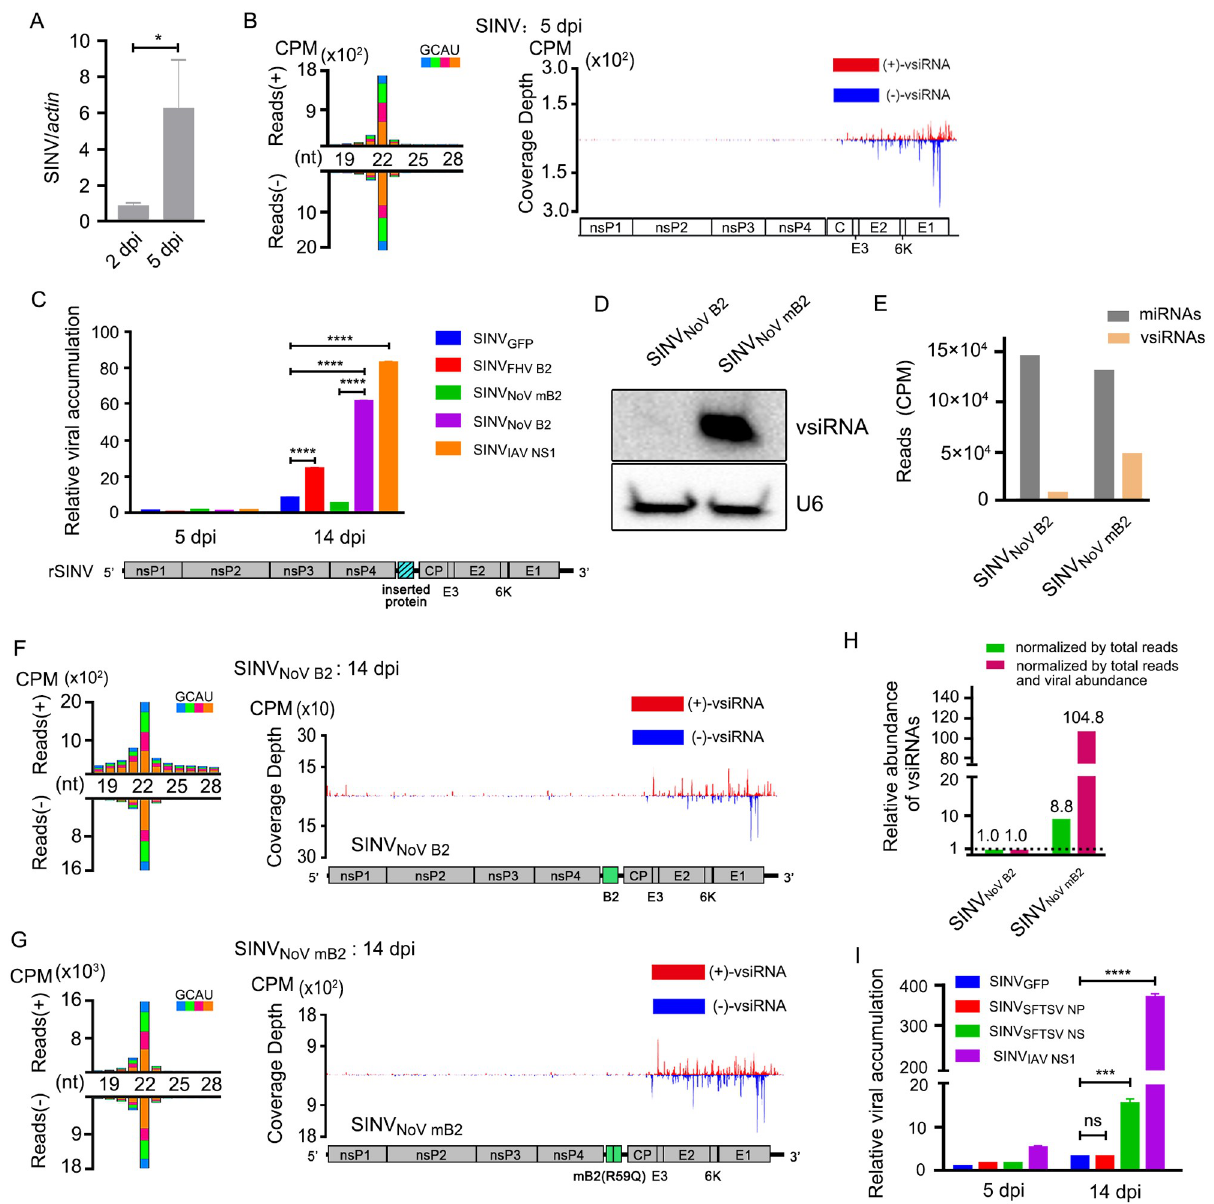
Fig 6. Infection of H . longicornis ticks with recombinant SINVs expressing heterologous VSR proteins. (A) SINV RNA levels in H . longicornis ticks infected with SINV by microinjection at 5dpi were determined by RT-qPCR. The viral RNA levels were calculated by Δ Ct method and tick β -actin mRNA was used as the internal reference. (B) Size distribution of virus-derived small RNAs and genomic coverage depth of 21- to 23-nt vsiRNAs sequenced from ticks infected with SINV by microinjection at 5 dpi. (C) Relative viral accumulation determined by RT-qPCR in ticks after infection with SINV GFP , SINV NoV B2 , SINV NoV mB2 , SINV FHV B2 , and SINV IAV NS1 by injection at 5dpi and 14 dpi. The viral RNA levels were calculated by ΔΔ Ct method. Tick β -actin mRNA as the internal reference. (D) Northern blotting detection of vsiRNAs in SINV NoV B2 and SINV NoV mB2 infected ticks by microinjection at 14 dpi. U6 as a loading control. (E) Reads of mature miRNAs and vsiRNAs in the library of SINV NoV B2 or SINV NoV mB2 infected ticks by microinjection at 14 dpi. (F and G) Size distribution of virus-derived small RNAs and genomic coverage depth of 21–23 nt vsiRNAs sequenced from ticks after infection with SINV NoV B2 (F) and SINV NoV mB2 (G) by microinjection at 14 dpi. (H) Relative abundance comparison of 21- to 23-nt vsiRNAs sequenced from ticks infected with SINV NoV B2 and SINV NoV mB2 at 14 dpi. Read counts were normalized either by total 21- to 23-nt reads only (green bar) or by both total 21- to 23-nt reads and viral relative accumulation determined by RT-qPCR (red bar). (I) Relative viral accumulations determined by RT-qPCR in ticks after infection with SINV GFP , SINV SFTSV NP , SINV SFTSV NS , and SINV IAV NS1 by microinjection at 14dpi. The viral RNA levels were calculated by ΔΔ Ct method. Tick β -actin mRNA as the internal reference. Error bars indicate the SEM of three biological replicates (5 nymphs per biological replicate). dpi: days post injection. Significance was determined by the Mann-Whitney test in (A) and ANOVA with Dunn’s tests in (C) and (I). ns: not significant, � P < 0.05, ��� P < 0.001, ���� P < 0.0001. Read counts are shown as per million total 18- to 28-nt reads (CPM) and the 5’